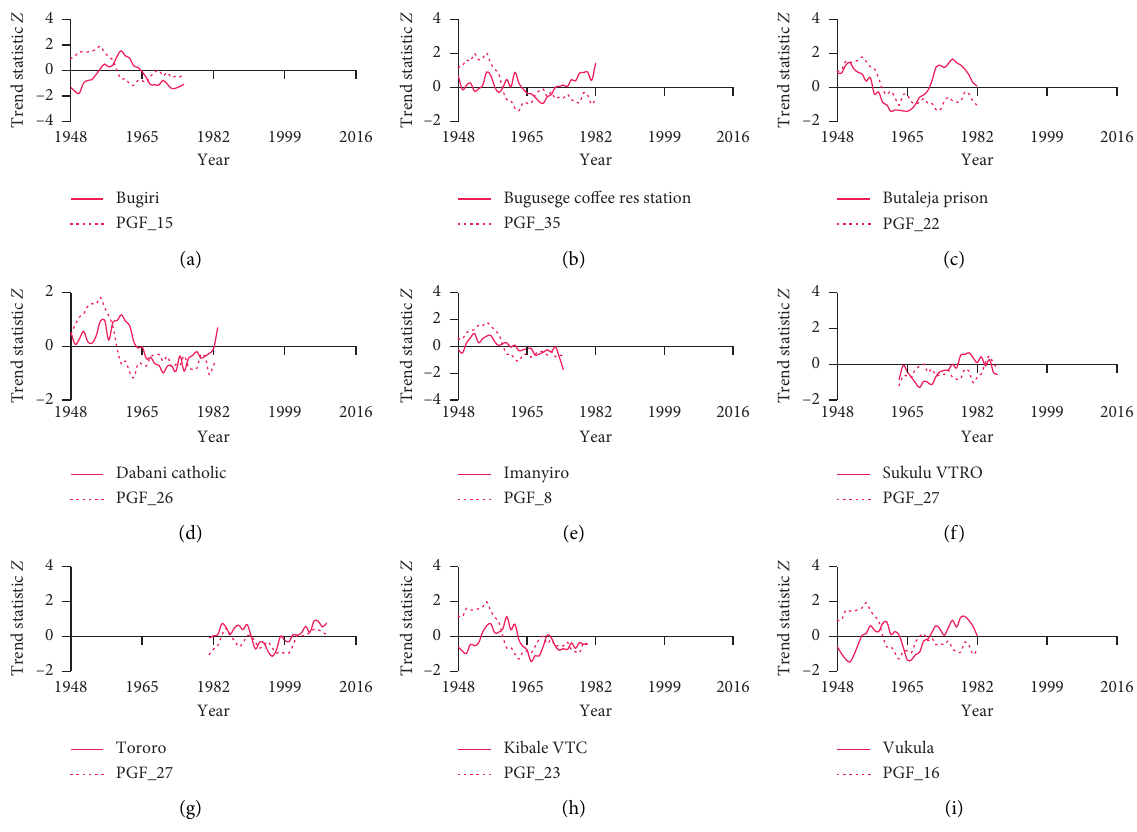
Figure 14: Variability of MAM PGF and observed rainfall at stations (a) 1, (b) 2, (c) 3, (d) 4, (e) 5, (f) 6, (g) 7, (h) 8, and (i)